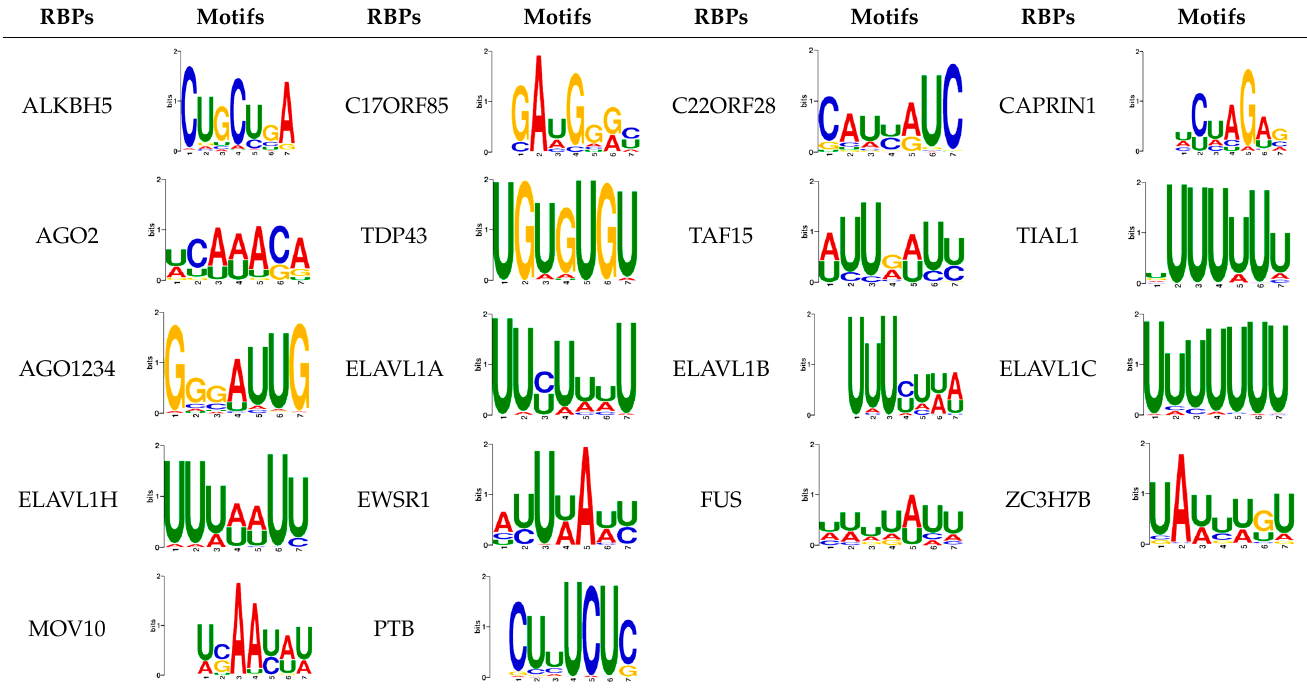
Table 5. Binding motifs extracted by the HPNet model but not in the database.